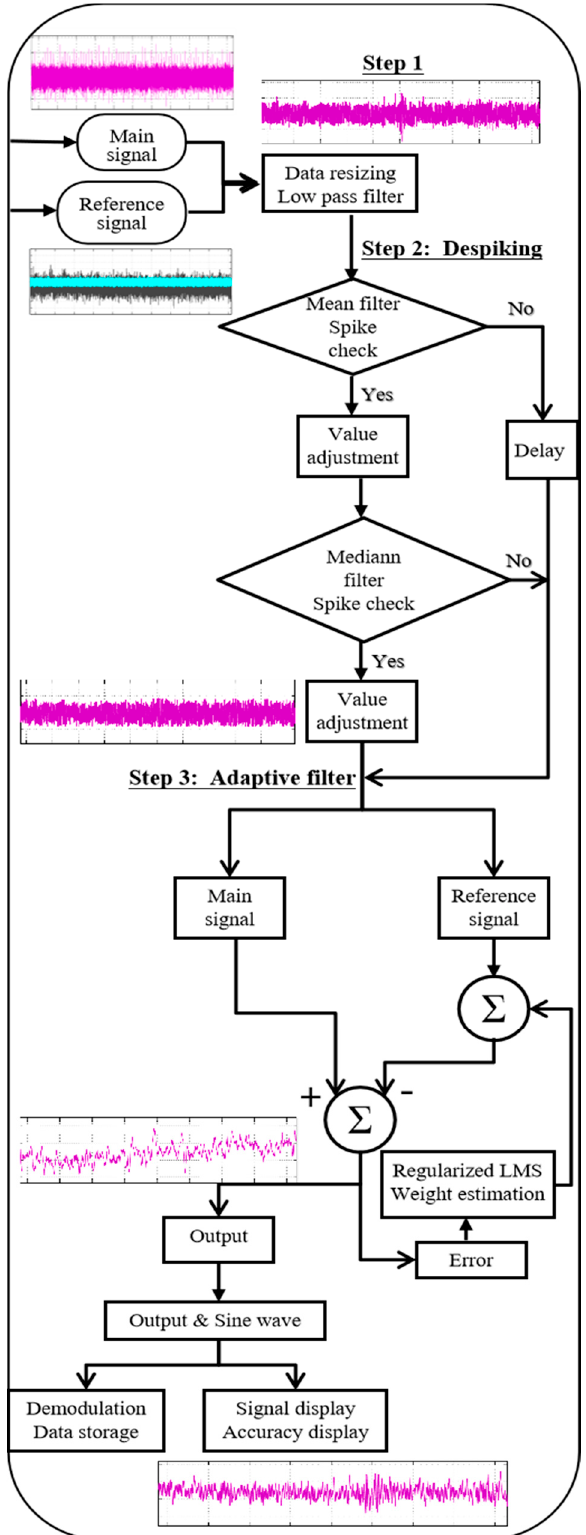
Figure 20. Adopted EM telemetry data processing workflow and corresponding data processing result from each step.